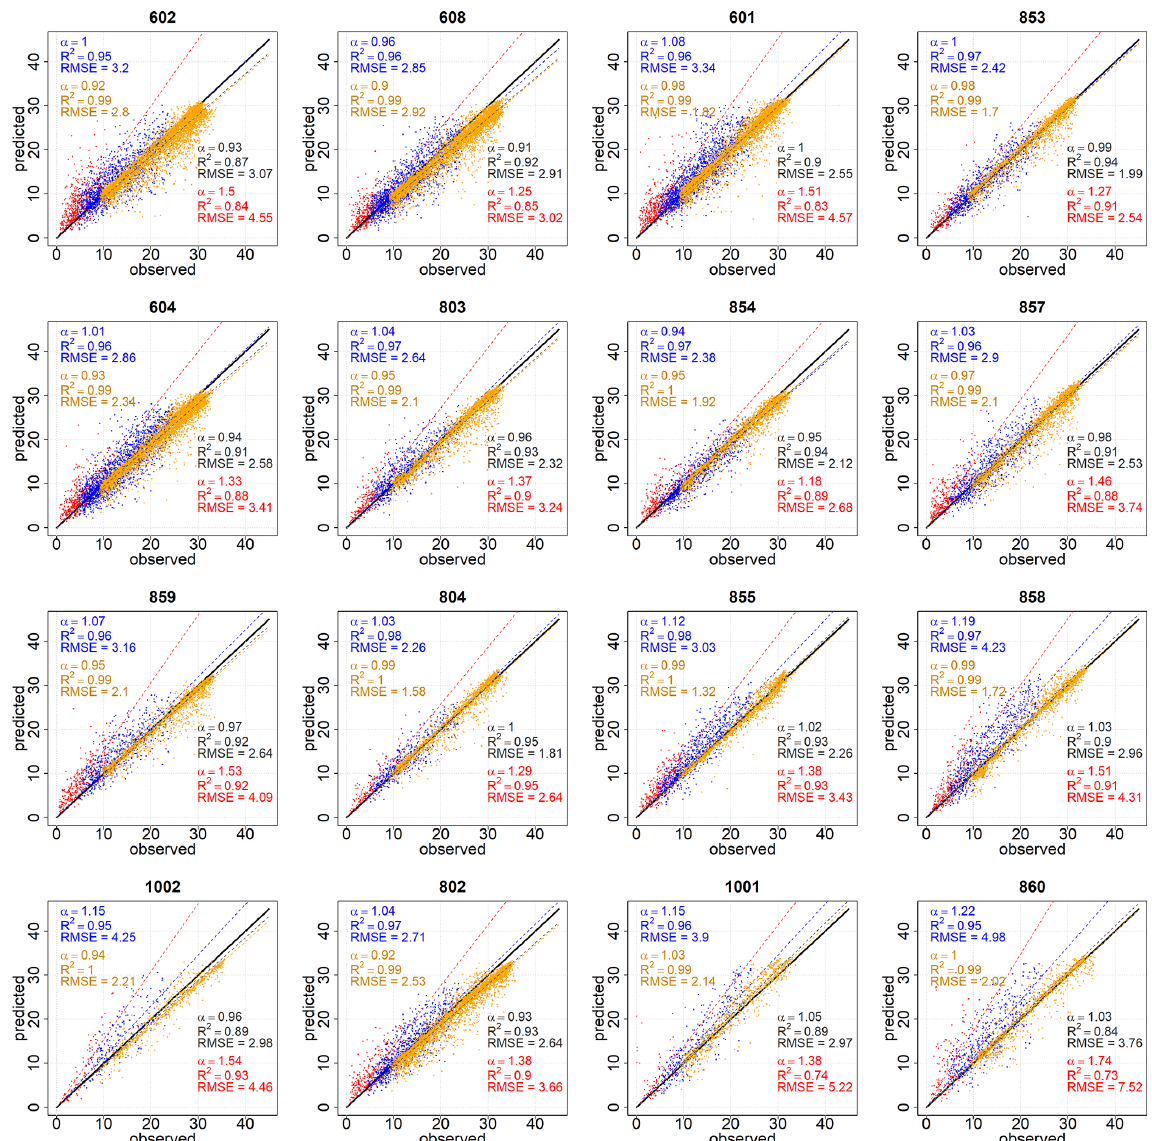
Figure 4. Cross-validation analysis. Linear fits of daily predicted vs. observed R g (MJm − 2 d − 1 ) at each of the selected stations for the global data (black) and cloudy (CI < 0.3 – red), partly cloudy (0.3 < CI < 0.6 – blue), and clear-sky (CI > 0.6 – orange) days. Stations are sorted by increasing altitude from left to right and from the top to the bottom